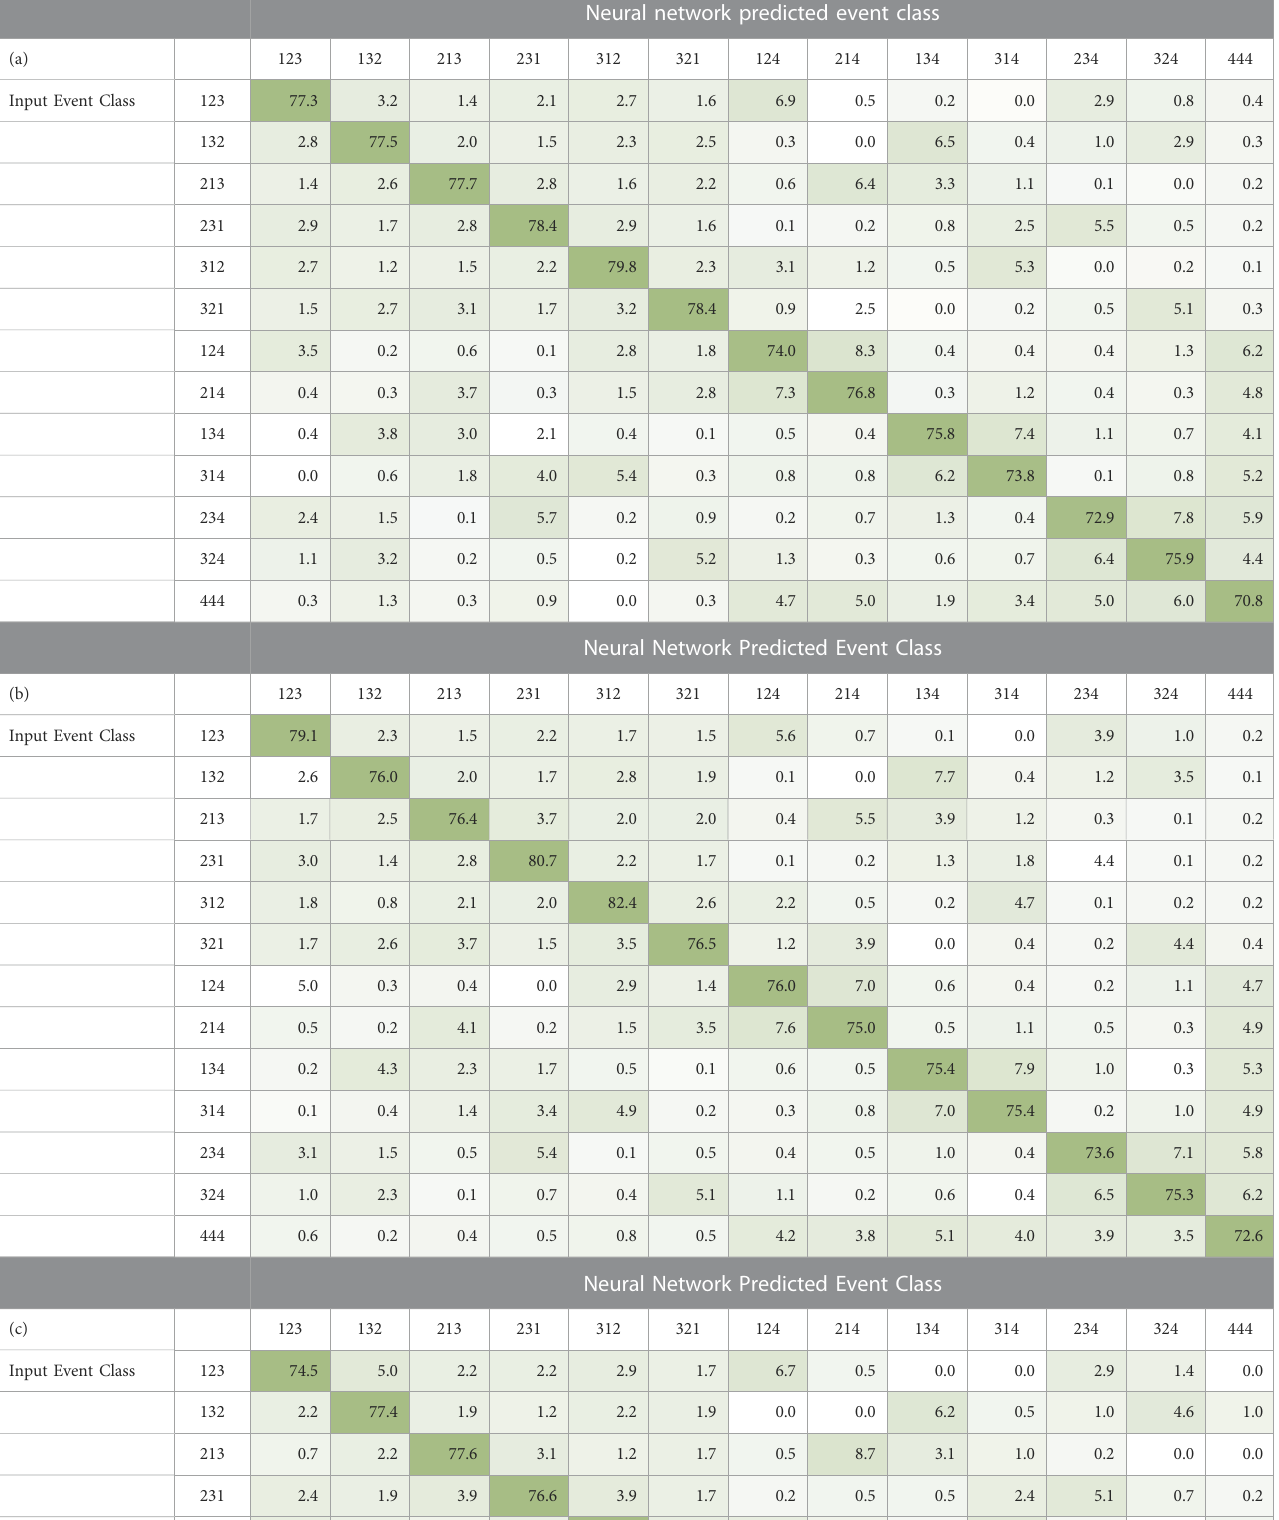
TABLE 2 Confusion matrix for a fully connected network trained on triples, double to triples, and false data from a 150 MeV beam for 18,000 epochs and tested on the MCDE model 150 MeV (a) 20 kMU/min, (b) 100 kMU/min, (c) 180 kMU/min beam. The 13 labels in the fi rst column are the input event class and the remaining 13 columns are the percentages of the input which were predicted to be the event class at the top of column by the NN. Each cell is colored by accuracy relative to the largest percentage present in the entire confusion